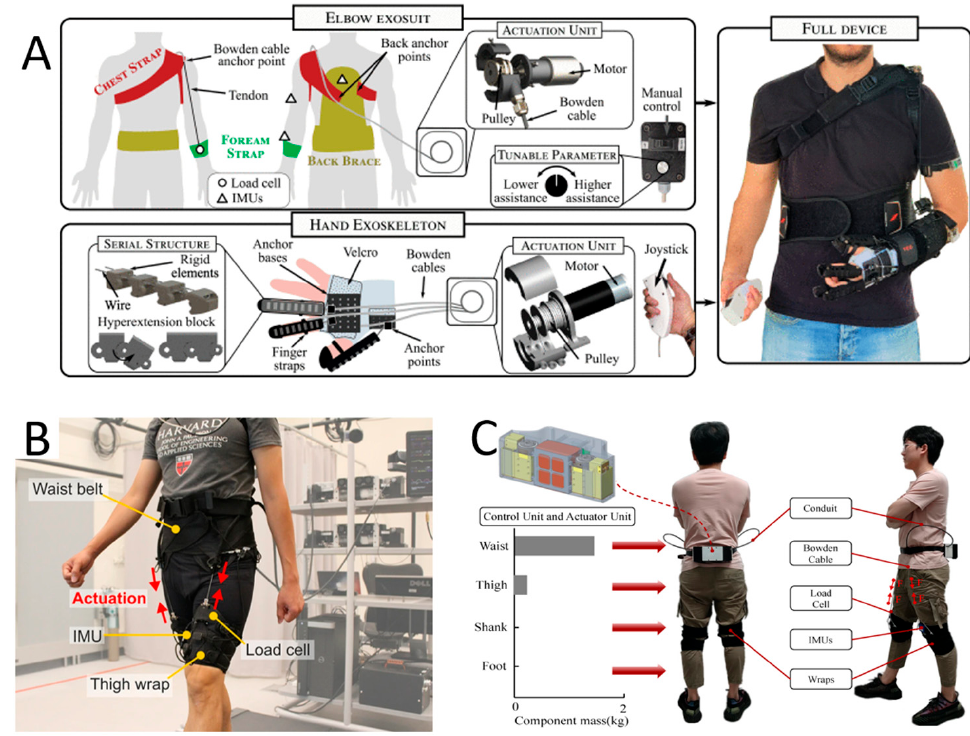
Figure 3. Illustrations of electric motor cable-driven soft wearables. ( A ) Noronha et al. [51] describe their work on a tethered soft exosuit that comprises an elbow wearable and a hand exoskeleton. ( B ) Kim et al. [42] describe their work on a tethered hip flexion exosuit which can reduce the metabolic rate of walking by up to 15.2%. ( C ) Chen et al. [63], on the other hand, show that their lower limb wearable can be controlled using a portable system.